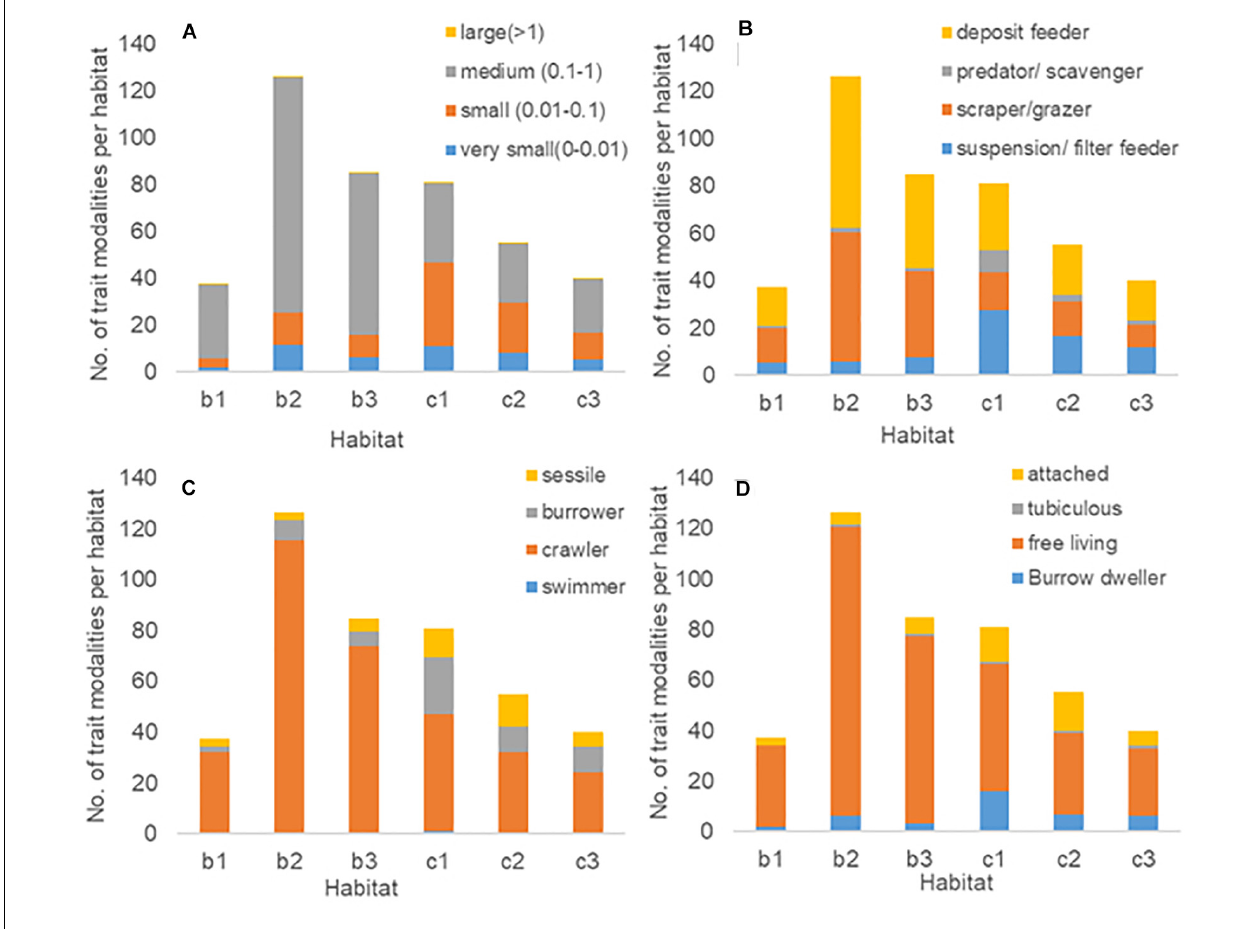
FIGURE 5 | Abundance of the trait modalities body size (A) , feeding habit (B) , movement (C) , and living habit (D) per habitat encompassing all